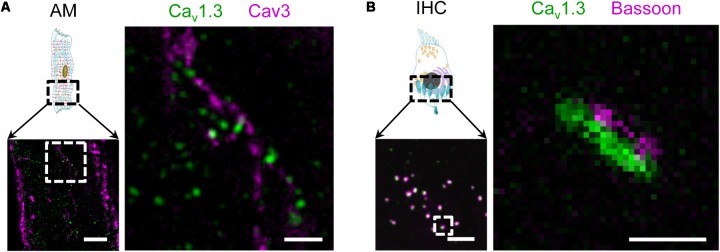
Surface expression of the LCC channel isoform Cav1.3 in AT structures of AMs and at the basal pole of inner hair cells (IHC). (A) Co-immunofluorescence STED imaging of Cav1.3 and Caveolin3 (Cav3) in an isolated mouse AM. Right: the magnified region (dashed box) shows Cav1.3 next to Cav3 clusters, the latter indicating AT membrane structures. Scale bars: left 2 μm; right 500 nm (magnification). (B)
Left: Confocal immunohistochemical imaging of Cav1.3 and the presynaptic scaffold protein bassoon showing a representative section of the IHC basal pole. Right: A magnified active zone obtained at higher resolution by STED microscopy. In synapses of IHCs, Cav1.3 channels are typically arranged in linear clusters and juxtaposed with bassoon. Scale bars: left 2 μm; right 200 nm (magnification).